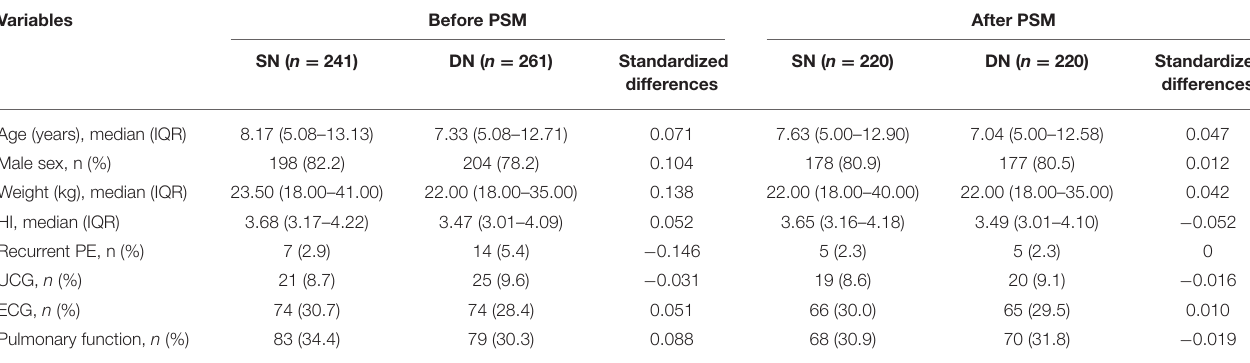
TABLE 1 | Demographics and clinical characteristics.